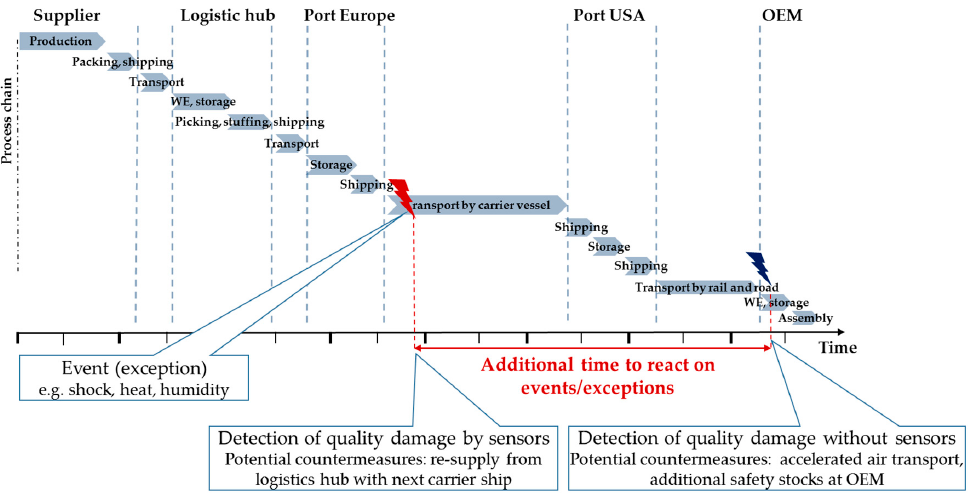
Figure 5. Earlier reaction to quality issues with sensor-based quality monitoring.